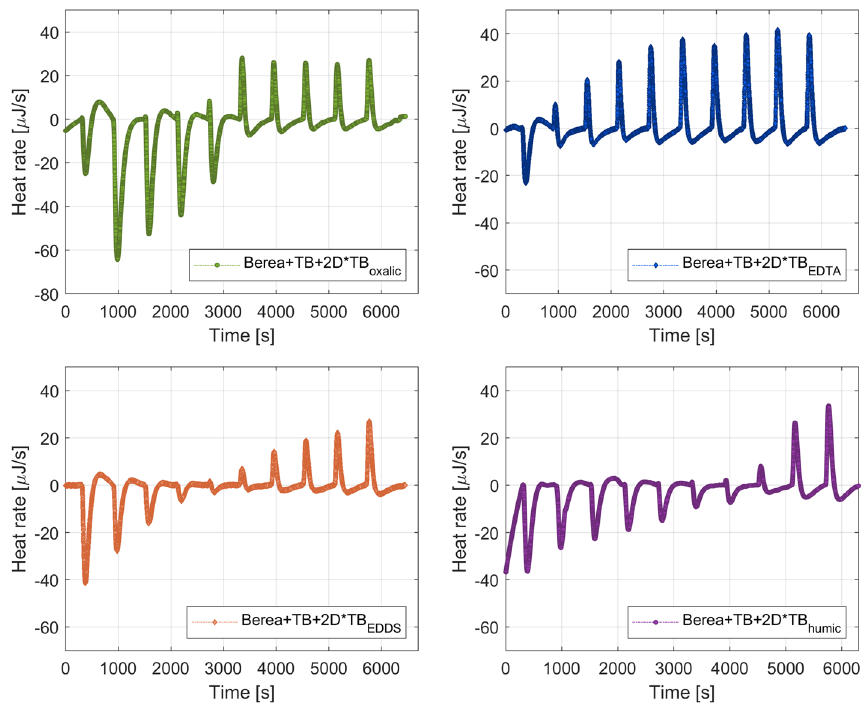
Fig. 5 Thermograms for the interaction of 2D * TB chelating and Berea